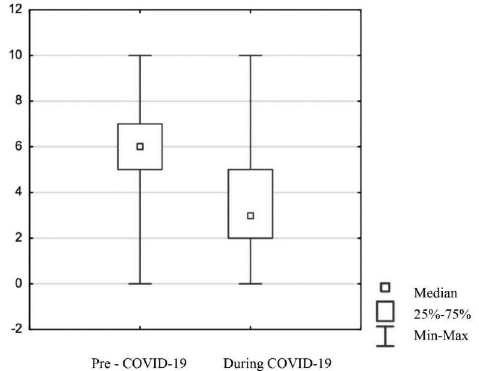
Figure 1. Comparison of scores concerning the access to health services before and during the COVID-19 pandemic for all respondents